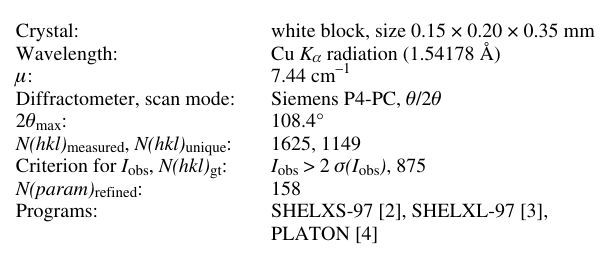
Table 1. Data collection and handling.